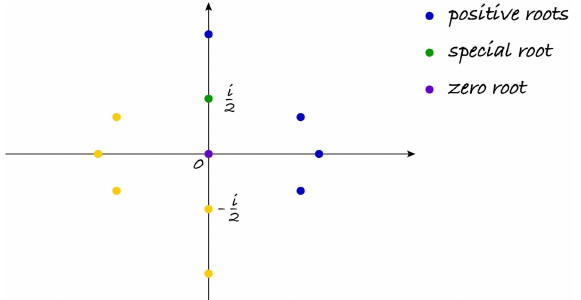
Figure 1 . A symmetric configuration of Bethe